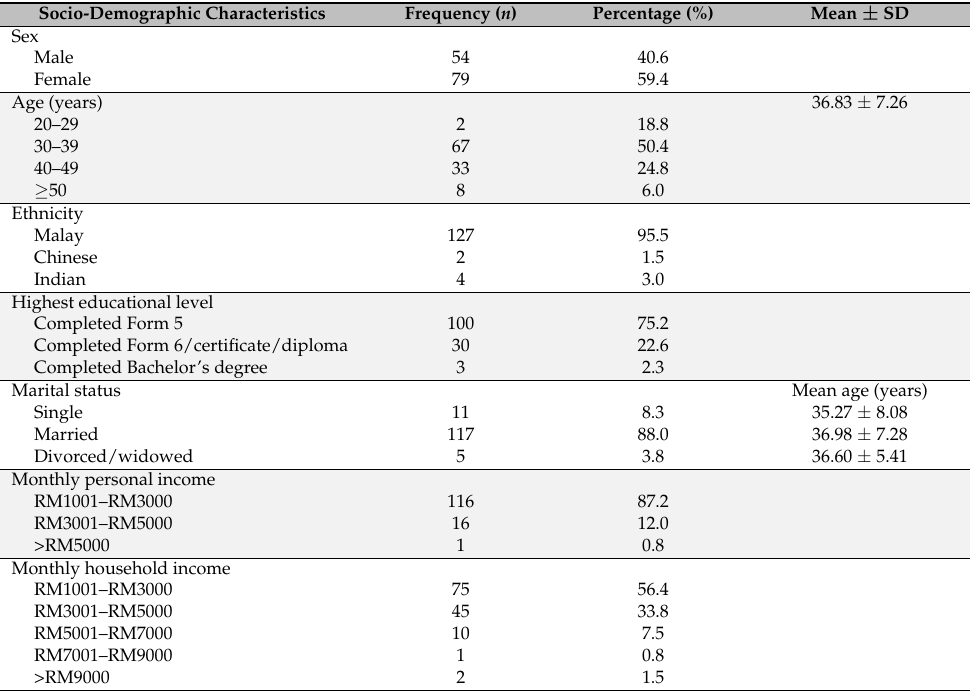
Table 4. Socio-demographic characteristics of subjects ( n =